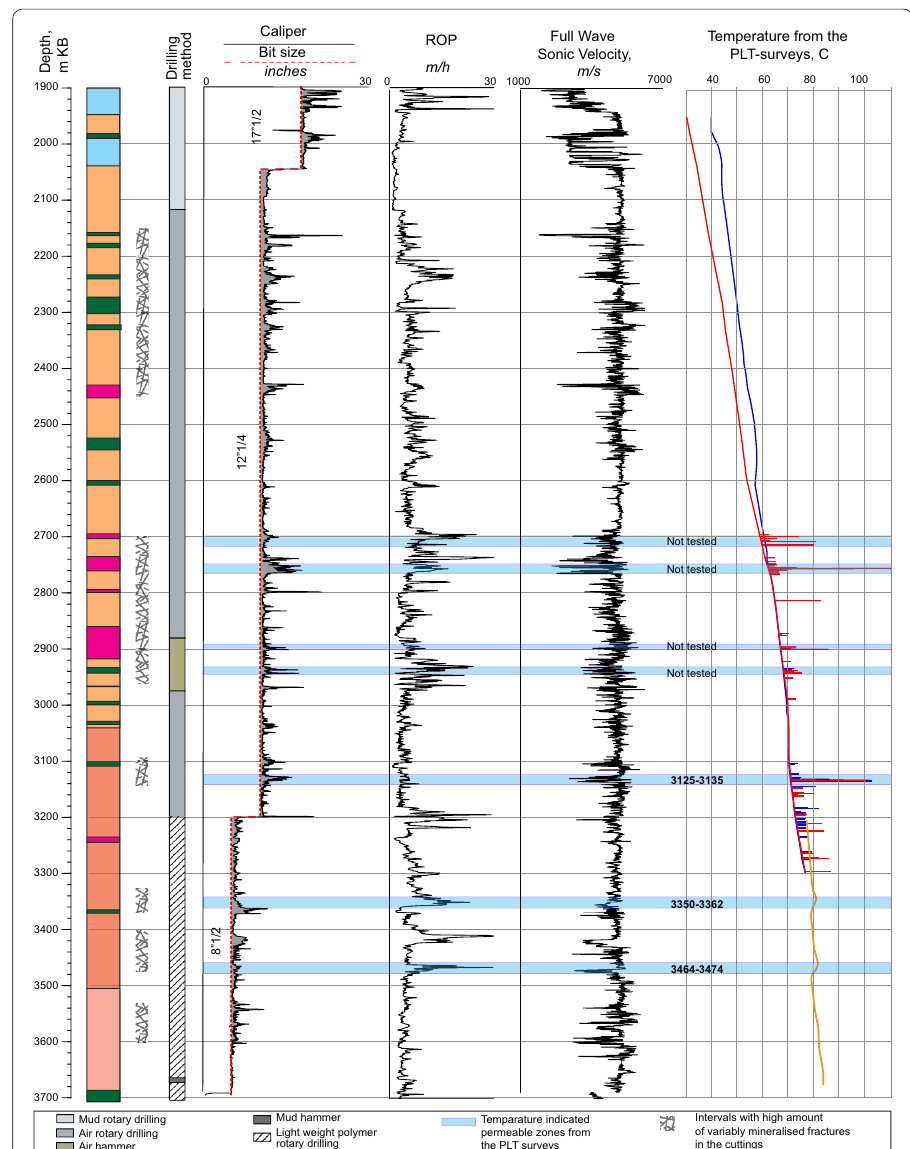
Fig. 6 Composite log illustrating lithology, drilling method, rate of penetration (ROP), caliper, full‑wave sonic velocity, and the PLT surveys. Intervals with noted increased fracturing and interpreted hydraulically conductive zones are marked. The lithology legend is shown in Fig.